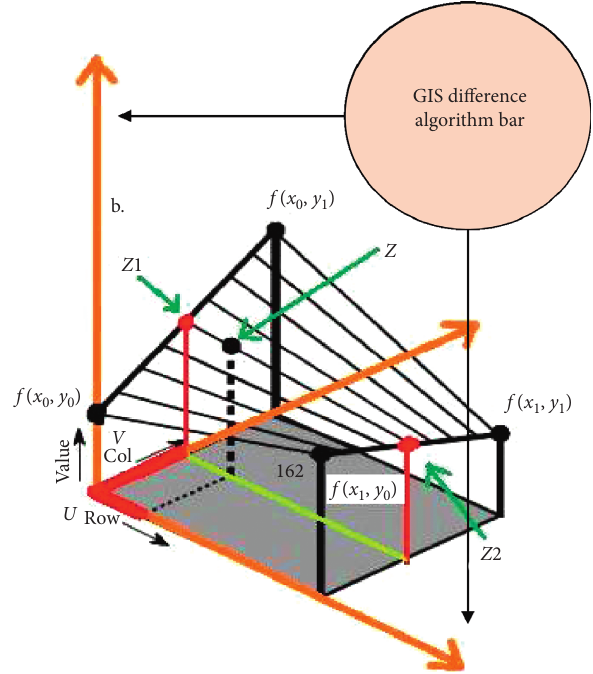
Figure 2: GIS surface deformation monitoring and early warning interpolation algorithm